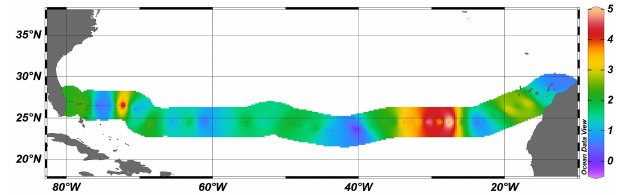
Figure 3. Sea-to-air CH 4 flux (µmolm − 2 d − 1 ) along the cruise track of JC191. Dots indicate stations occupied by CTD